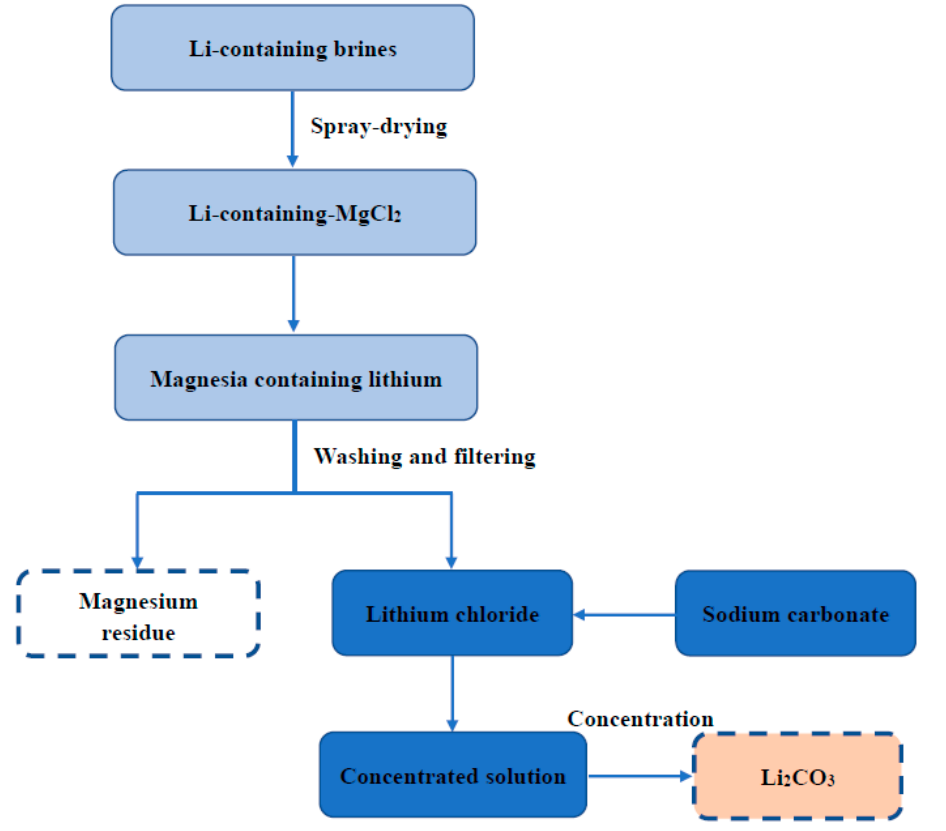
Figure 1. The technology route of Li 2 CO 3 production by calcination from salt lake.